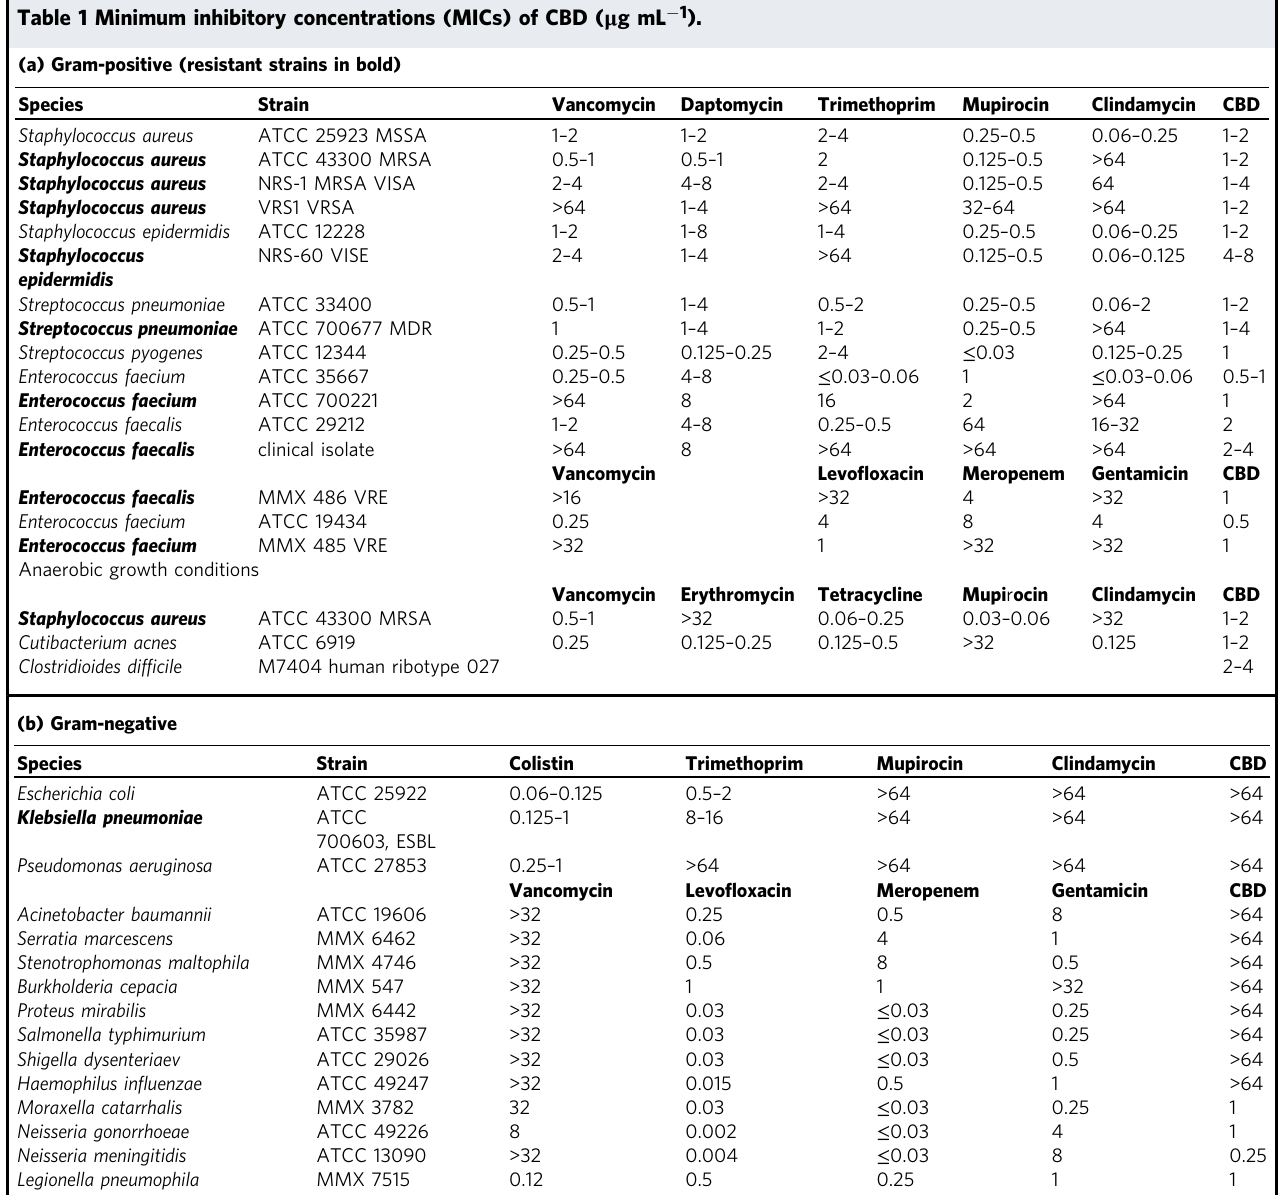
Table 10). The same effect was observed with polymyxin B